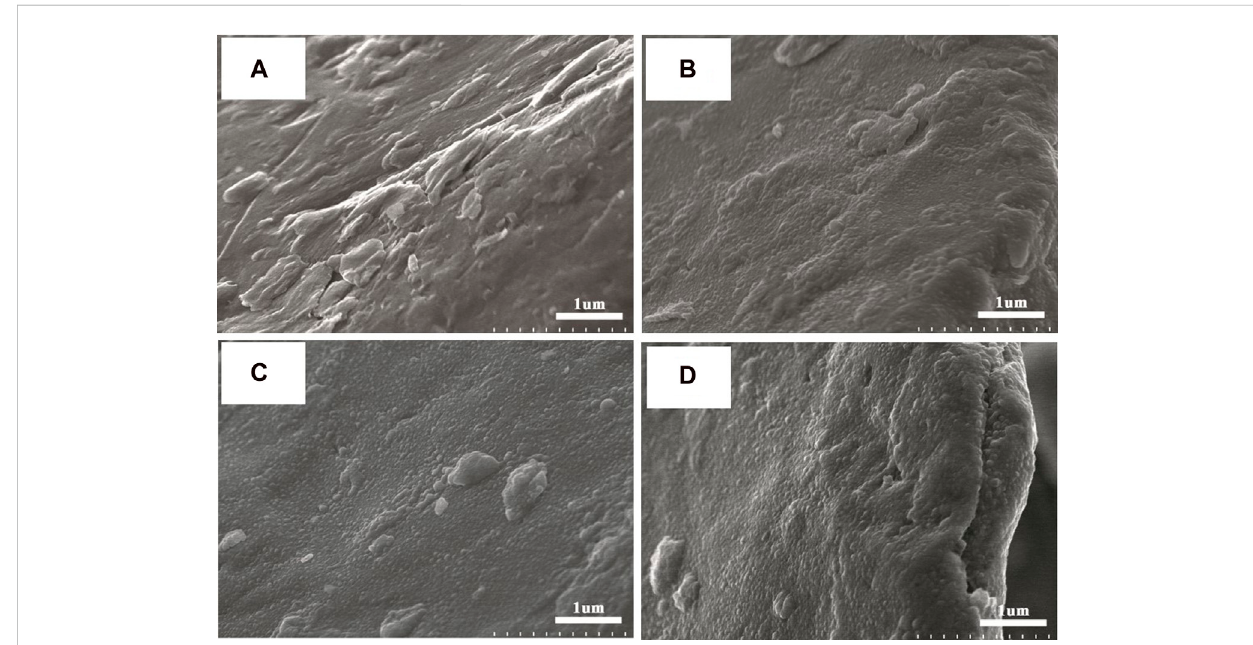
FIGURE 1 SEM images of FeCoCr powders after heat treatment at 400 ° C for different time: (A) raw, (B) 1 h, (C) 5 h, (D) 10 h.